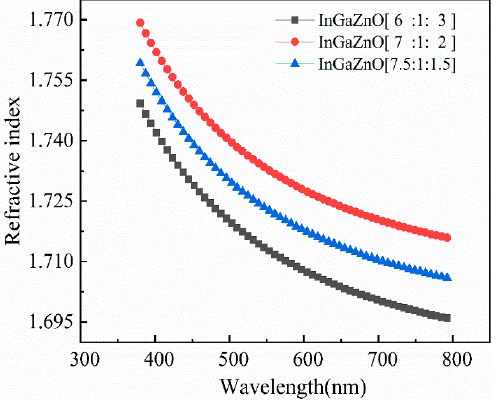
Figure 5. Relationship between refractive index of thin film.